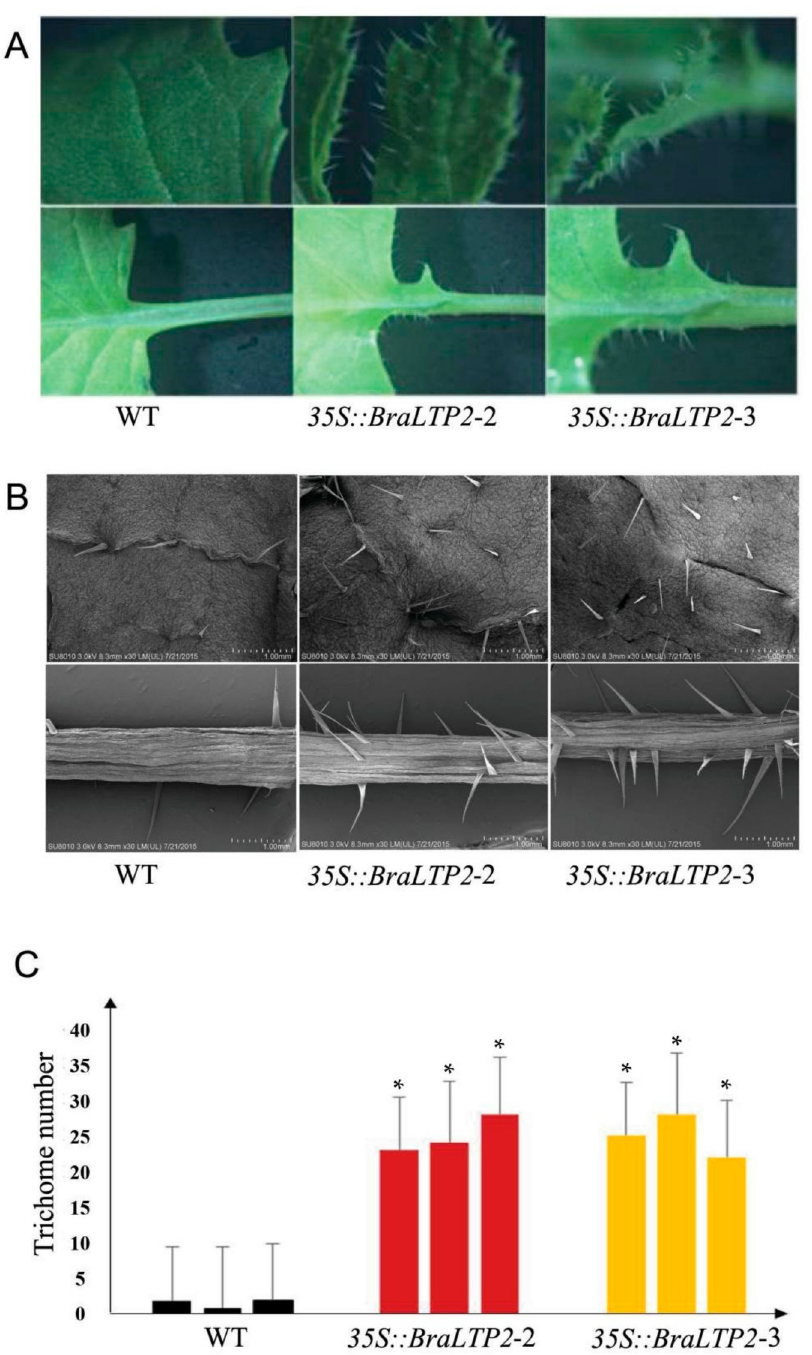
The 35S::BraLTP2 plants show no difference in plant height and plant morphology when compared with WT plants, however, the transgenic plants exhibit a hairy leaf surface, which is not observed in WT plants. This phenotypic feature of the 35S::BraLTP2 plants was a result of densely distributed trichomes, visible on both abaxial/adaxial leaf surfaces and petiole, when compared with WT plants (Figure 5A).